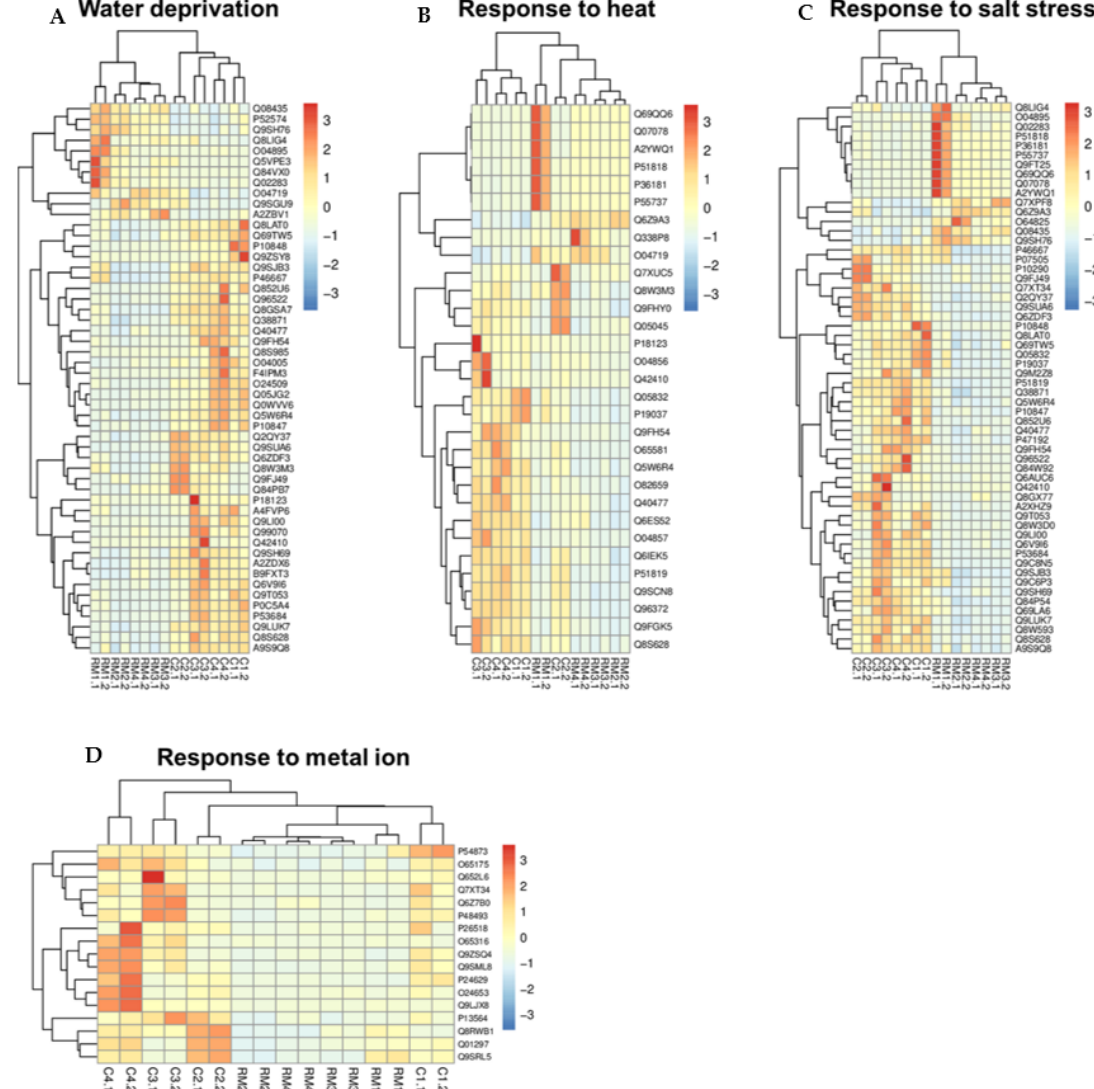
Figure 3. Hierarchical clustering of differentially abundant proteins related to abiotic stimulus in M. acutistipula sampled from RM (RM1.1, RM1.2, RM2.1, RM2.2, RM3.1, RM3.2, RM4.1, and RM4.2) and canga (C1.1, C1.2, C2.1, C2.2, C3.1, C3.2, C4.1, and C4.2). ( A ) Water deprivation. ( B ) Response to heat. ( C ) Response to salt stress. ( D ) Response to metal ion. The red and blue colors represent the highest and lowest intensity values, respectively. The accession numbers represent the proteins used for the analysis and can be viewed in Dataset